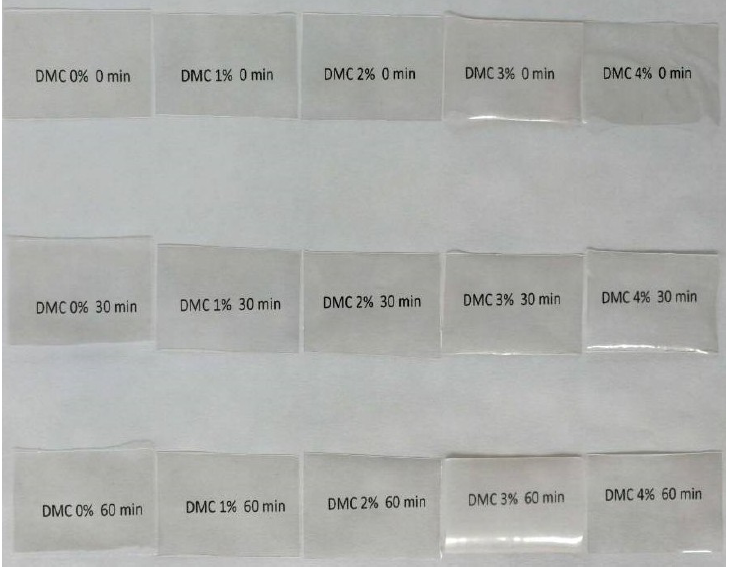
Figure 4. Photography of different composite films under different ultrasound.